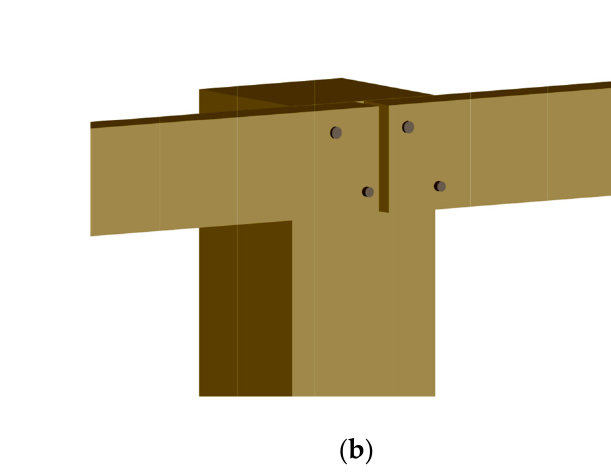
Figure 2. ( a ). The 2 × 4 × 8 spacing between each post, and ( b ) each 2 × 4 being connected to the center face of 6 × 6 s with two 2-1/2 ″ brown deck screws spaced diagonally, where inside 2 × 4 connections should have a small gap to allow expansion.